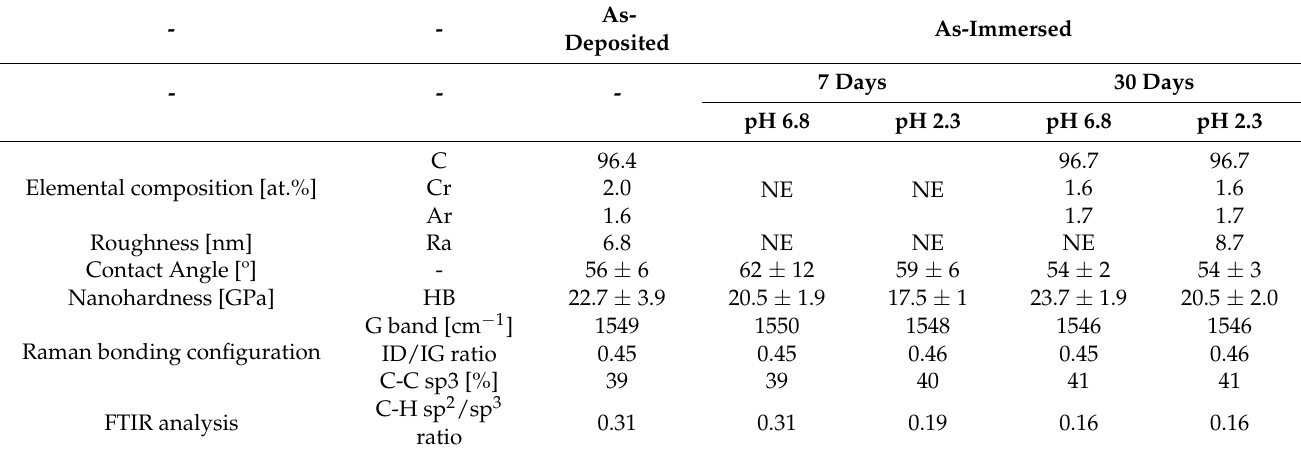
Table 4. Main characteristics of the a-C:H coatings before and after corrosion